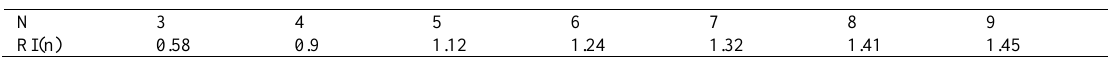
Table 2. Random index